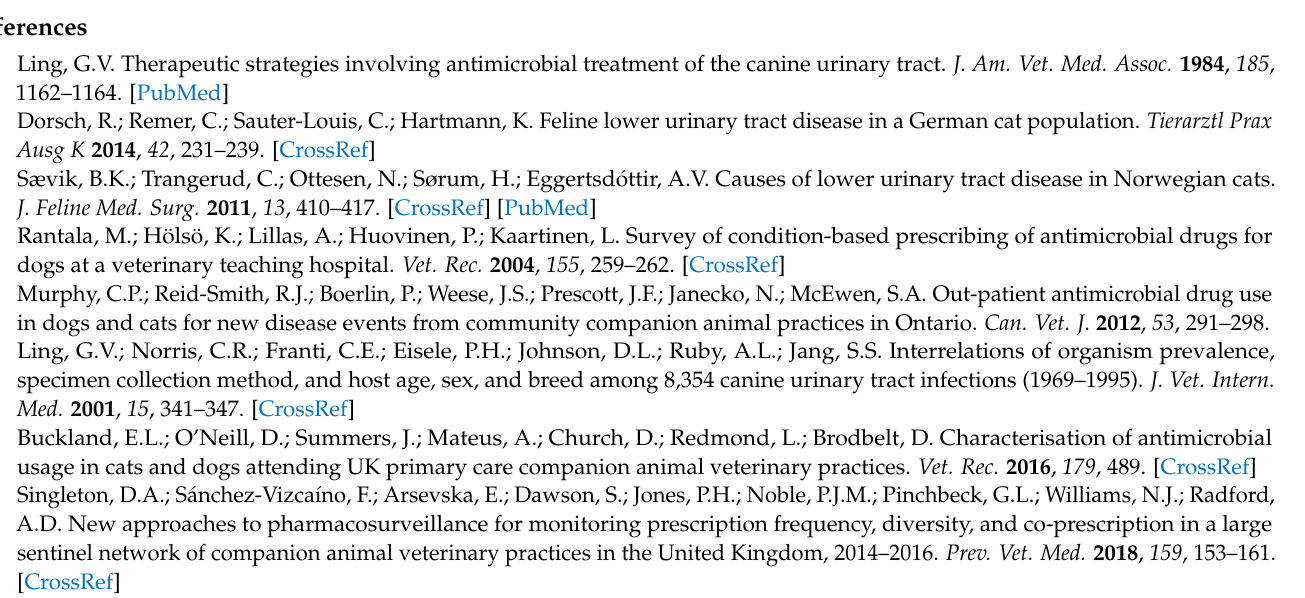
of various antimicrobials against 66 enterococci isolates cultured from dogs with urinary tract infec- tion; Table S7: Activity of various antimicrobials against 46 Sc. canis isolates cultured from dogs with urinary tract infection; Table S8: Activity of various antimicrobials against 11 Proteus spp. isolates cultured from cats with urinary tract infection; Table S9: Activity of various antimicrobials against 15 Enterobacter cloacae complex (ECC) isolates cultured from cats with urinary tract infection; Table S10: Activity of various antimicrobials against 13 Pseudomonas aeruginosa isolates cultured from cats with urinary tract infection; Table S11: Activity of various antimicrobials against 50 en- terococci isolates cultured from cats with urinary tract infection; Table S12: Activity of various antimicrobials against coagulase-negative staphylococci (CoNS) isolates cultured from cats with urinary tract infection; Table S13: Number of susceptible isolates among cats and dogs suffering of UTI presented by animal and